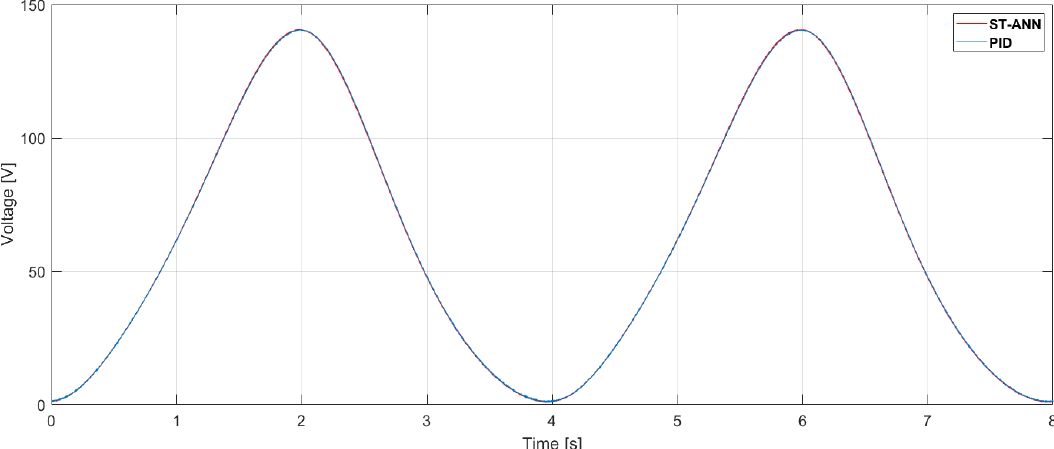
Figure 10. Control signal comparison between the ST-ANN and the PID structures for a sine wave tracking reference.